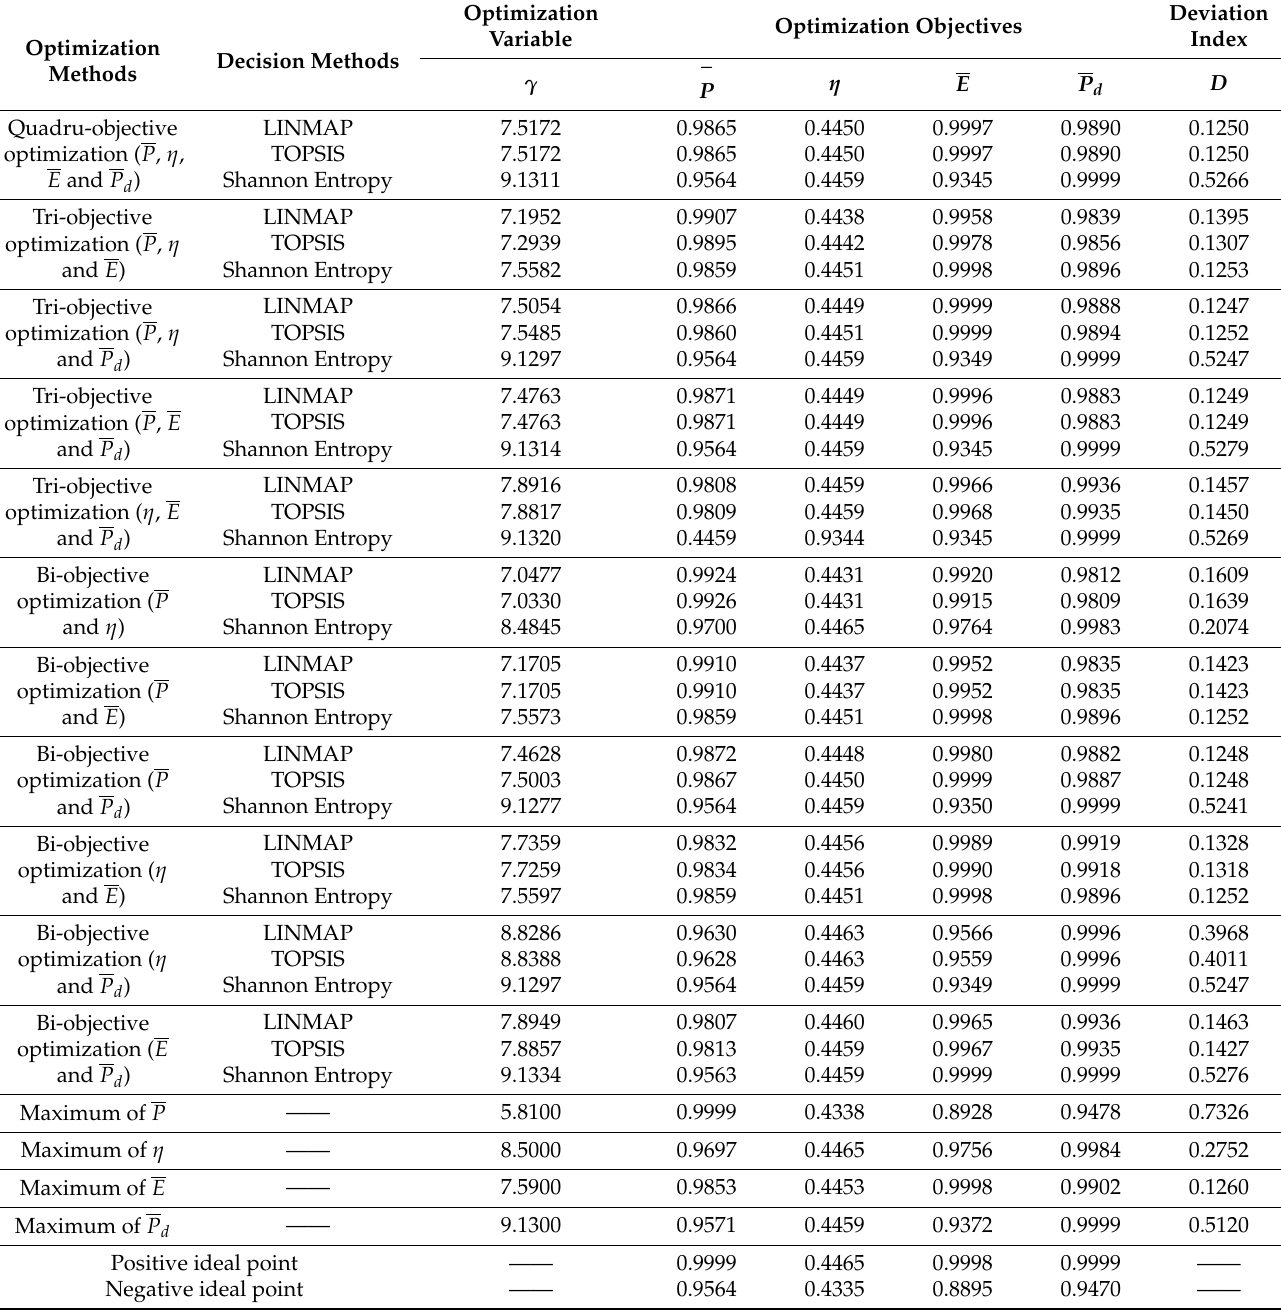
Table 1. Outcomes of decision-making methods for MOO and single-objective